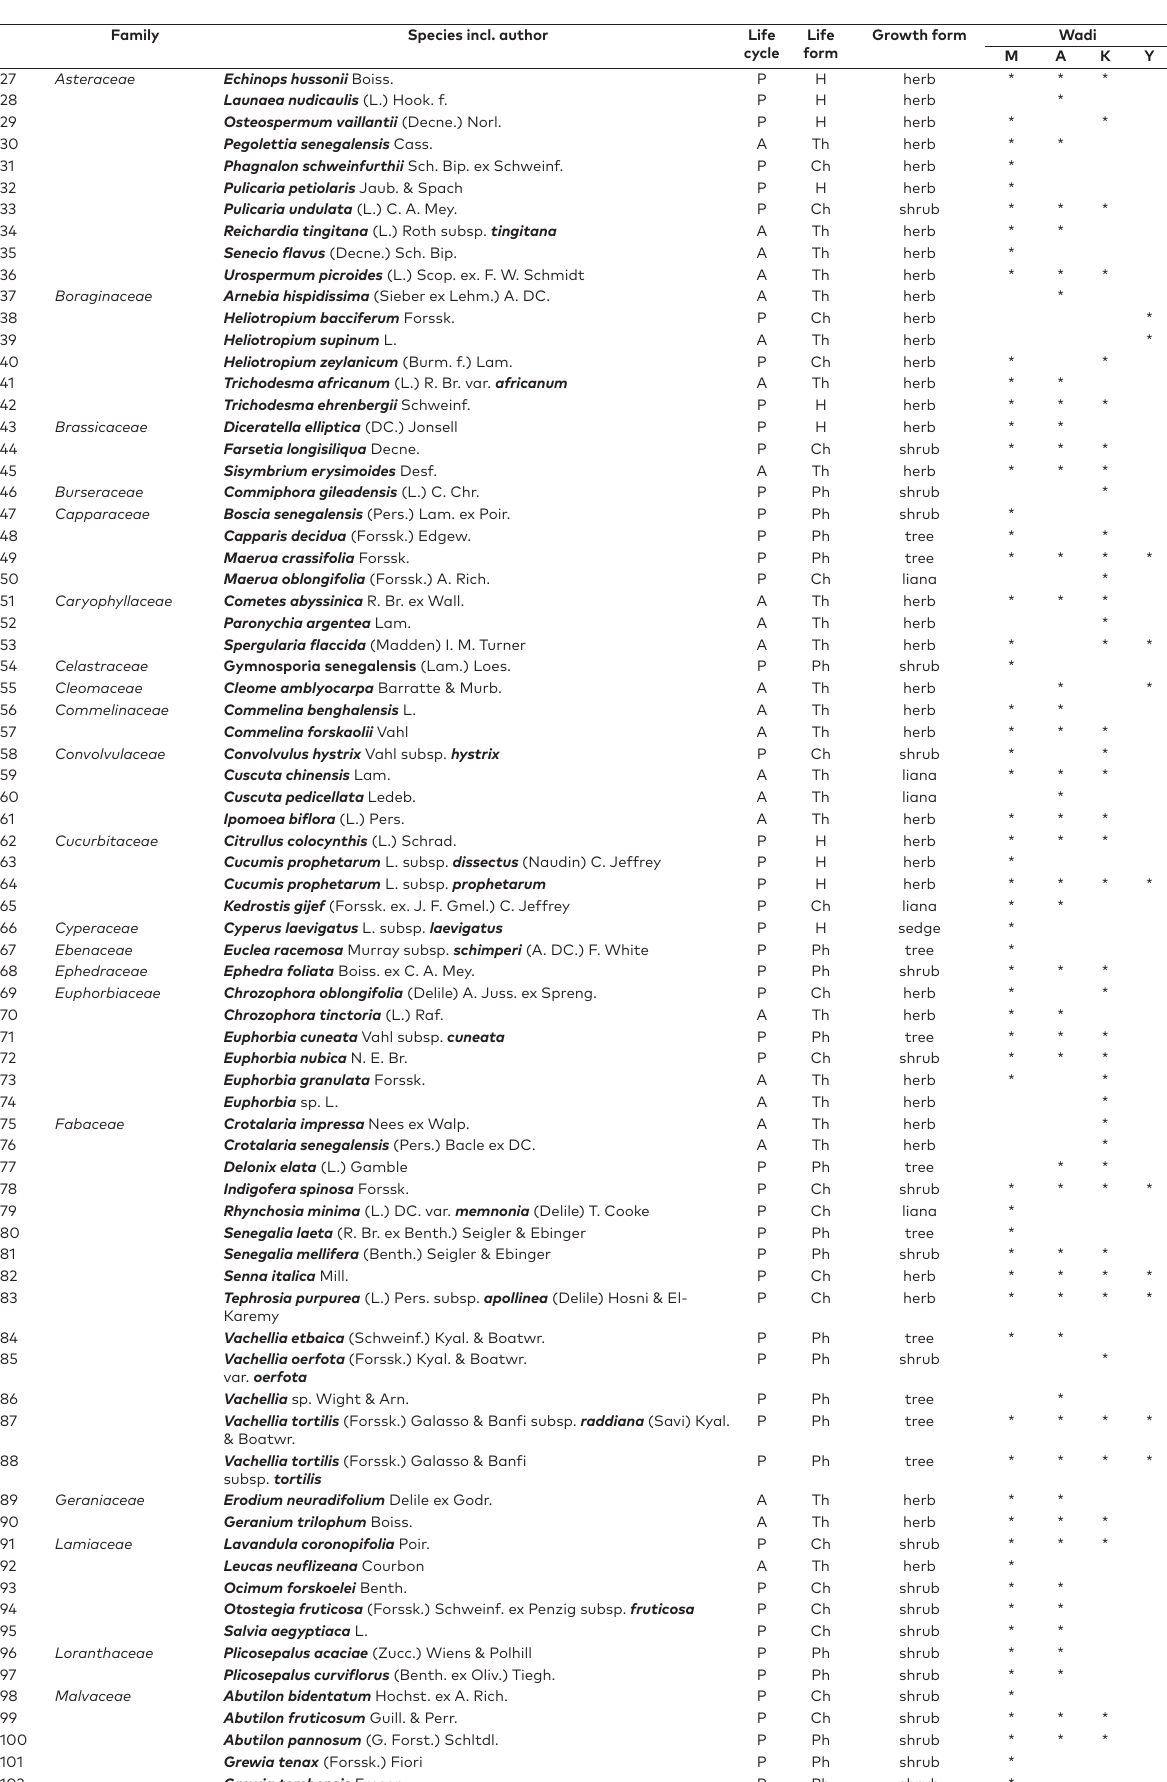
Asteraceae Echinops hussonii Boiss. H herb Launaea nudicaulis (L.) Hook. f. H herb Osteospermum vaillantii (Decne.) Norl.